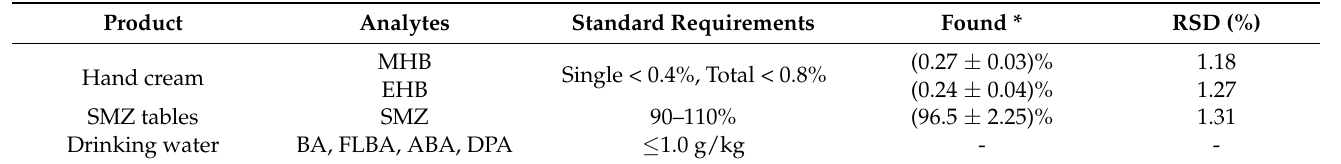
Table 6. Assay data for the practical